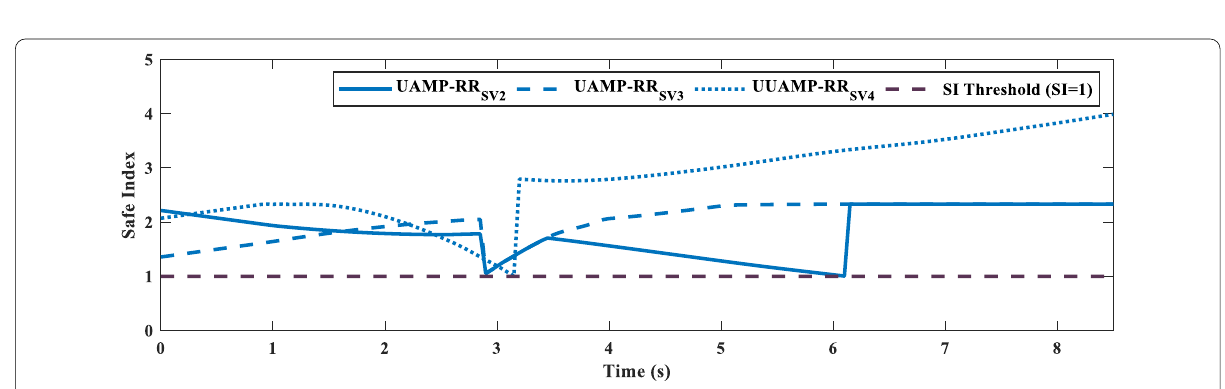
Figure 7 SI values of UAMP-RR for other SVs in case 1